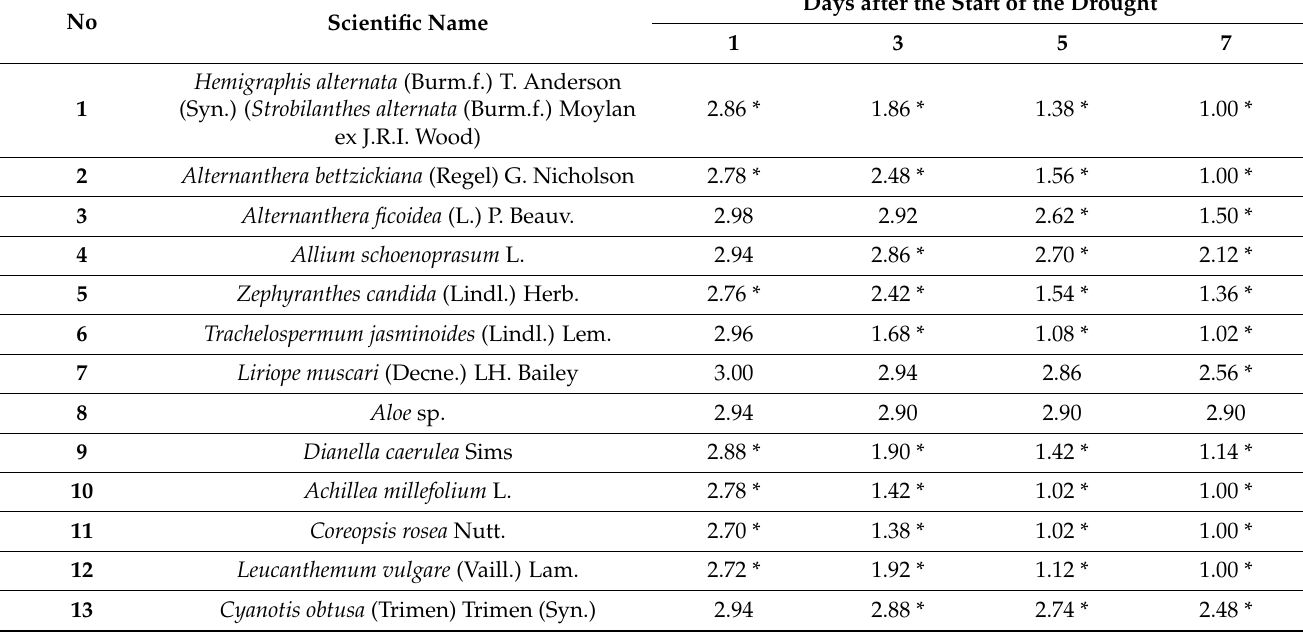
Table A1. Esthetic scores of 25 plant species under the drought treated condition at 1, 3, 5, and 7 days after the start of the experiment. (3: the maximum degree of a healthy plant exhibiting as the starting day. Significant difference (*) at p < 0.05 by Student’s t-test from the control